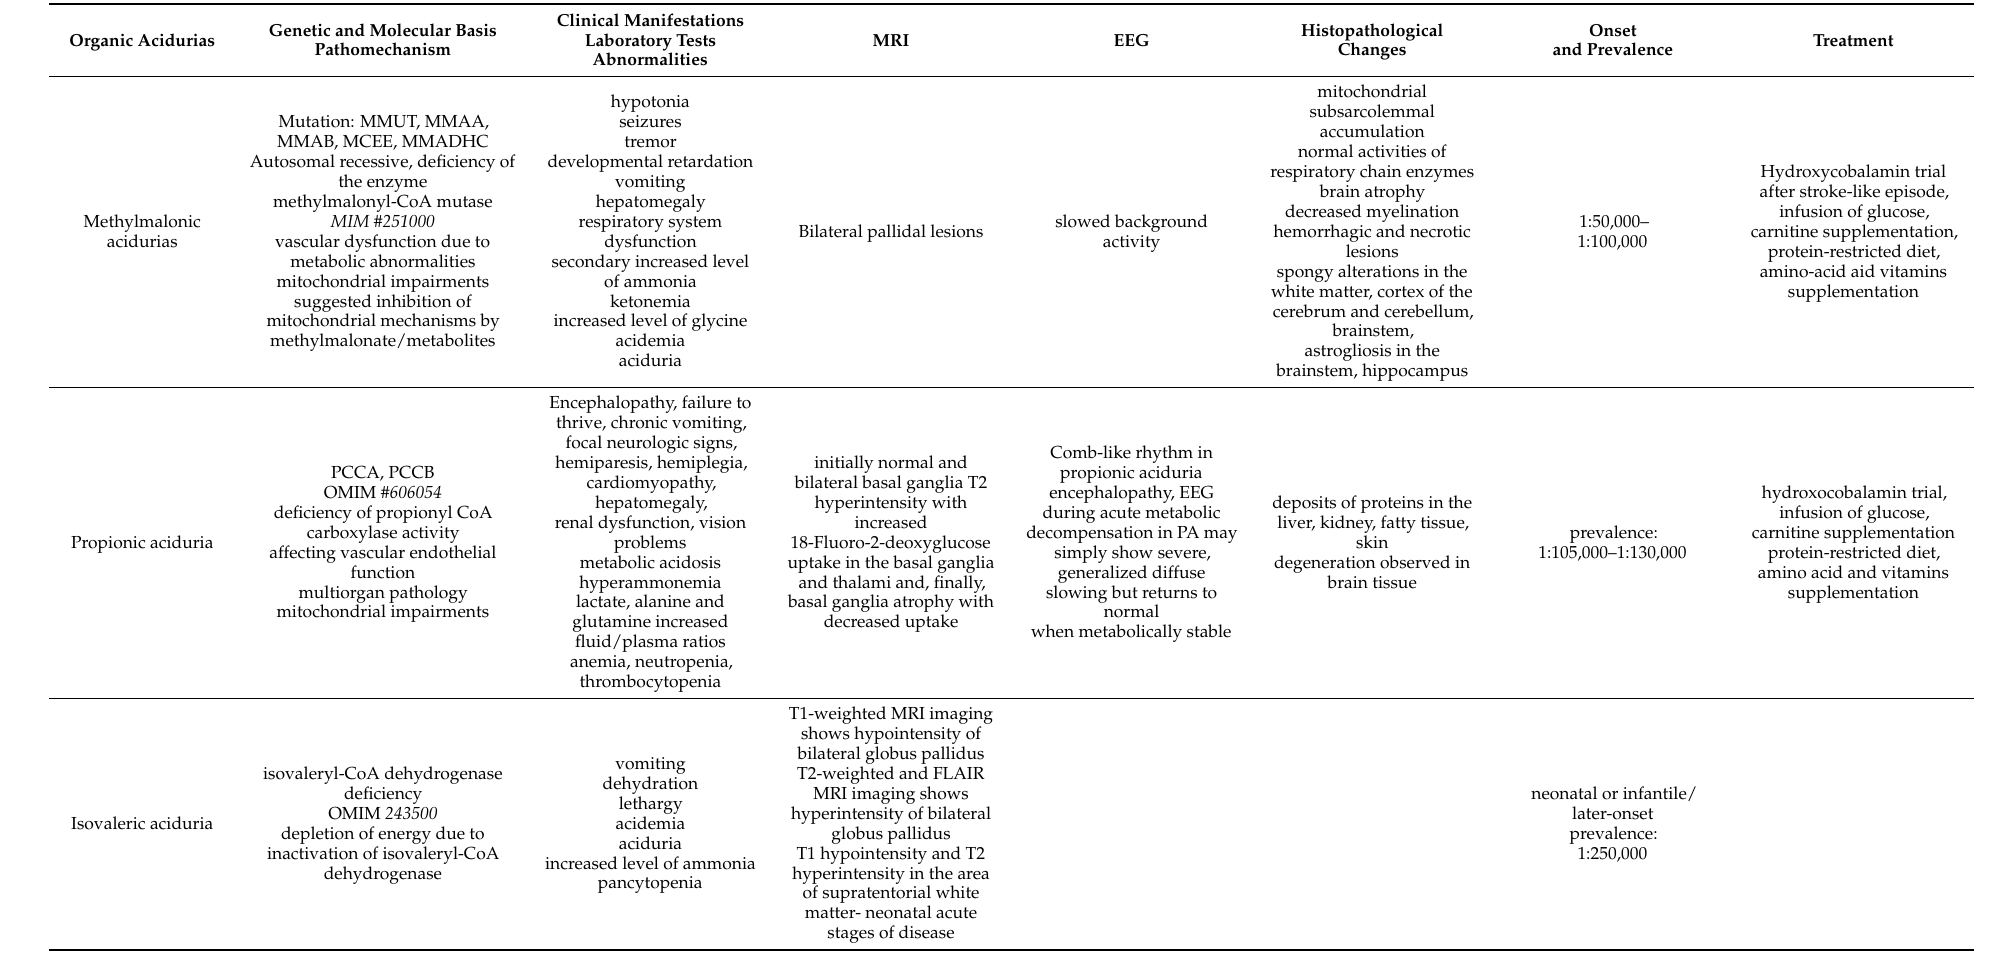
Table 2. This table shows characteristic features of various neurometabolic disorders—organic